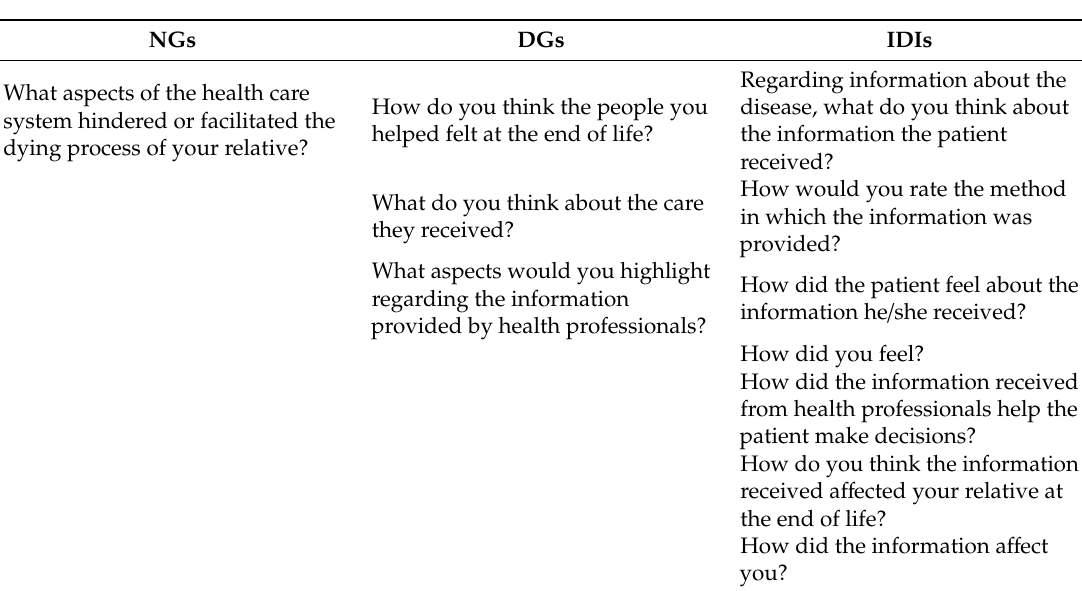
Table 1. Question script: nominal groups (NGs), discussion groups (DGs), and in-depth interviews (IDIs). NGs DGs IDIs What aspects of the health care system hindered or facilitated the dying process of your